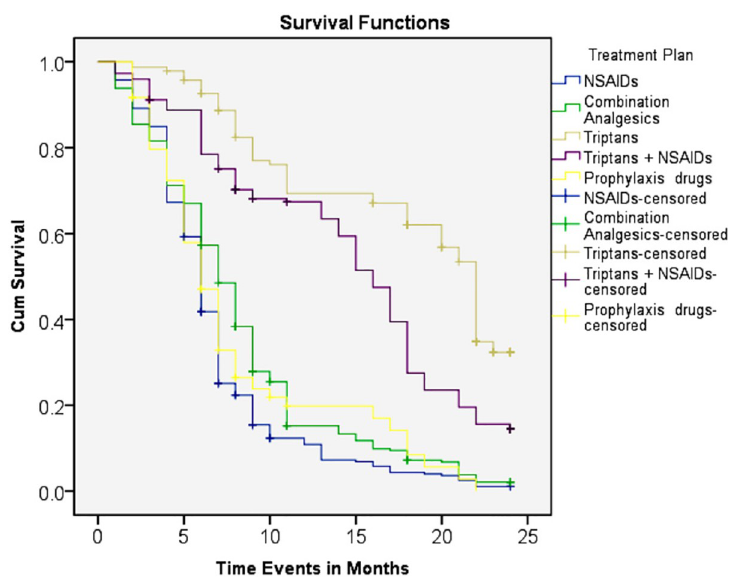
Fig 1. Kaplan–Meier curves showing an adjusted cumulative probability of treatment persistence for 24 months after by anti-migraine drugs.